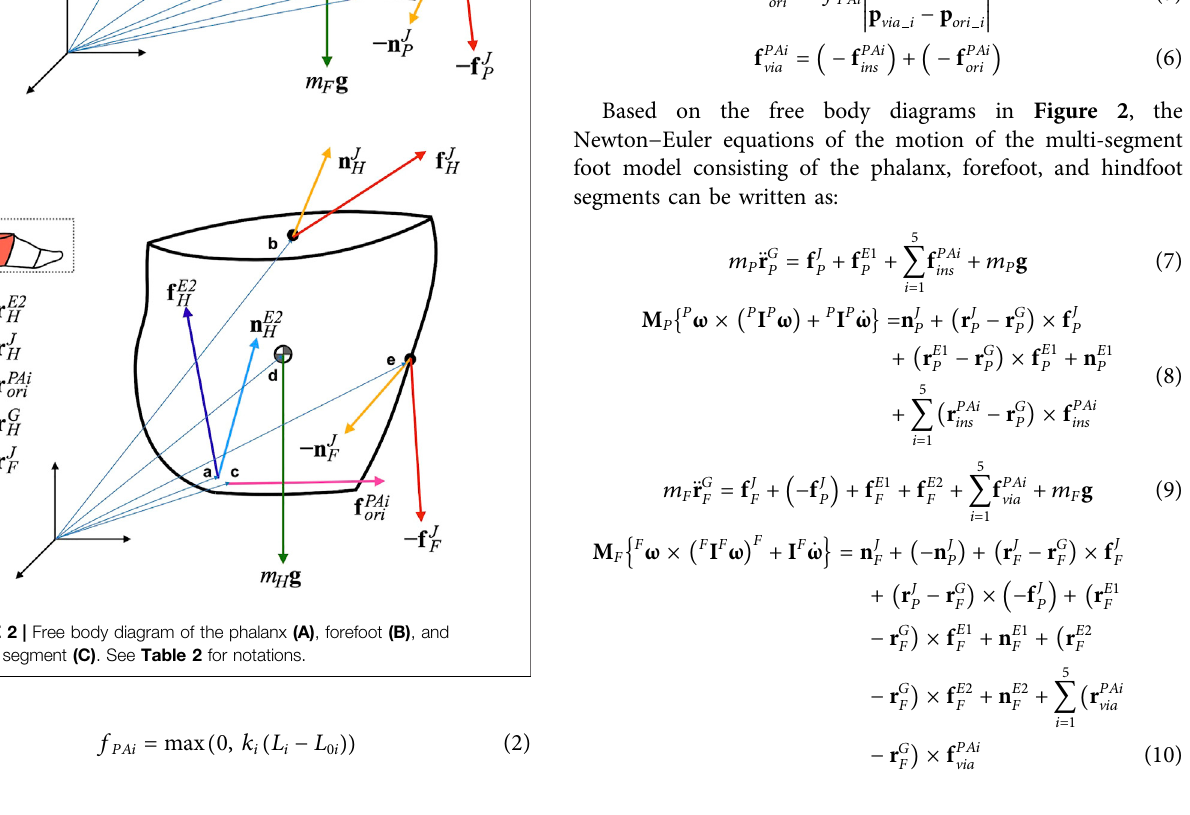
Frontiers in Bioengineering and Biotechnology |